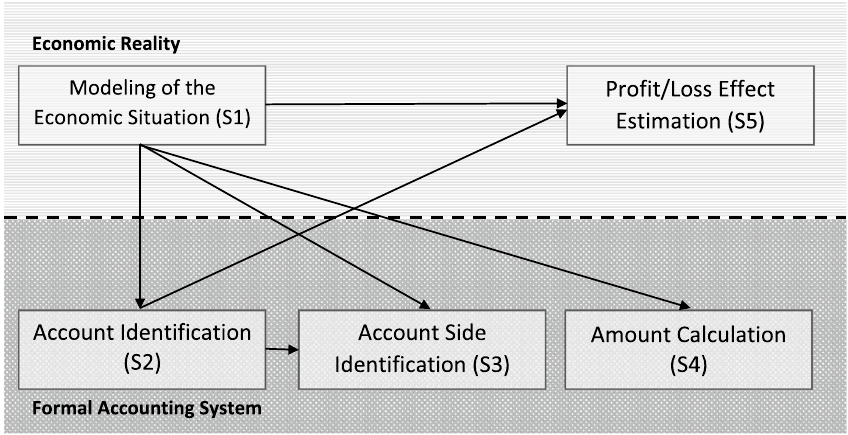
Fig. 2 Competence Model depicting cognitive skills (S1-S5) required for processing tasks in the domain of introductory